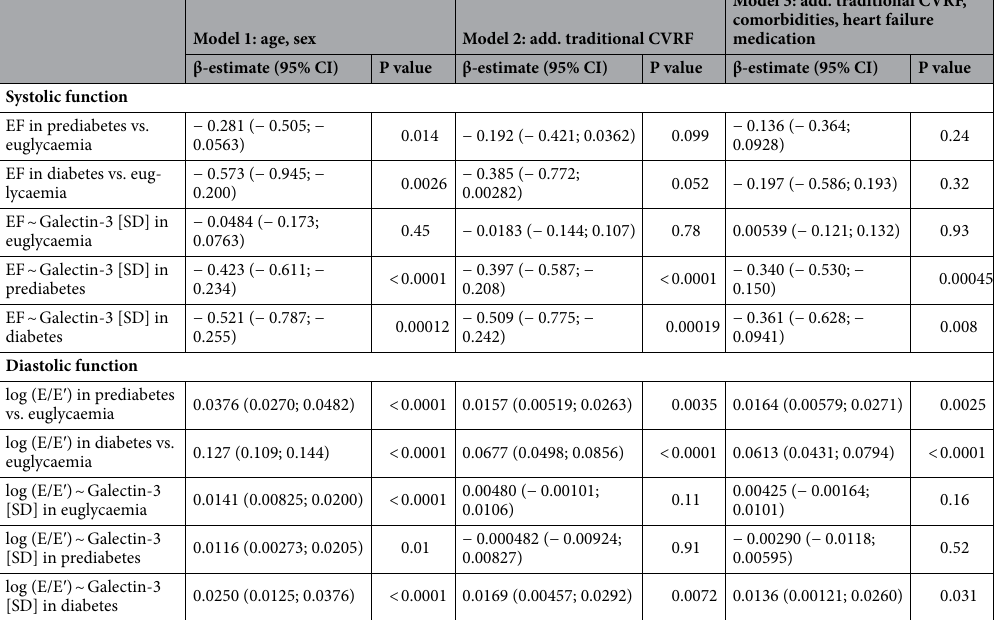
Table 2. Cross-sectional association between galectin-3 and cardiac function in prediabetes and type 2 diabetes mellitus. Multiple linear regression models for investigation of the association between Galectin-3 (increase per standard deviation respectively 5 ng/ml) and EF as well as log(E/E ′ ) in prediabetes and diabetes compared to euglycaemia within the baseline data. Model 1 adjusted for sex and age. Model 2 adjusted for sex, age, hypertension, dyslipidemia, obesity, smoking, FH of MI/stroke. Model 3 adjusted for sex, age, hypertension, dyslipidemia, obesity, smoking, FH of MI/Stroke, atrial fibrillation, chronic kidney disease, chronic liver disease, congestive heart failure, coronary artery disease, myocardial infarction, peripheral artery disease, stroke, venous thromboembolism, heart failure medication intake. CVRF cardiovascular risk factors, SD standard